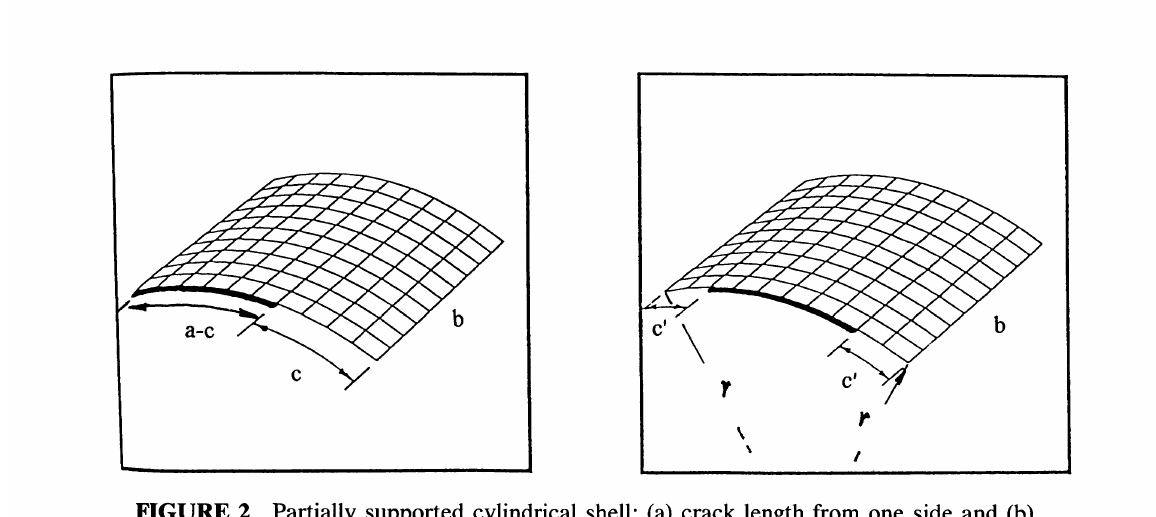
FIGURE 2 Partially supported cylindrical shell: (a) crack length from one side and (b) crack length from the two